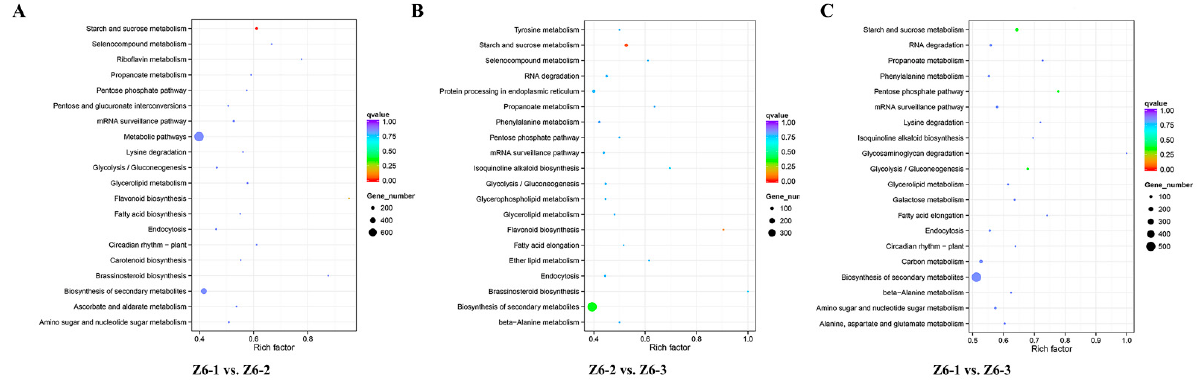
Figure 9. KEGG pathway enrichment analysis of target genes of differentially expressed miRNAs on pairwise comparisons. ( A ) Comparison of Z6-1 vs. Z6-2. ( B ) Comparison of Z6-2 vs. Z6-3. ( C ) Comparison of Z6-1 vs. Z6-3.